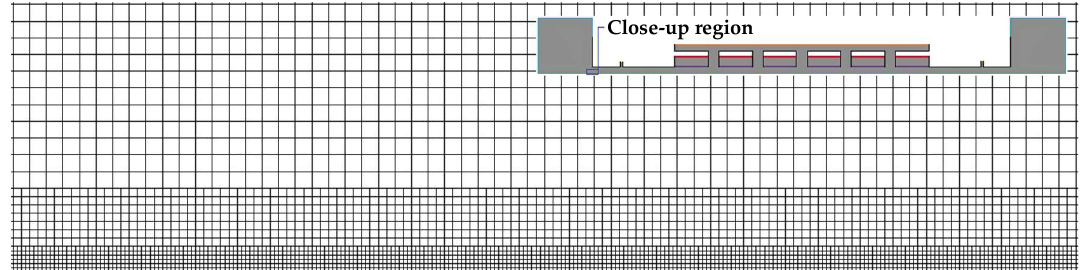
Figure 6. Close-up at fluid domain inlet of the mapped mesh showing element refinement on textile.